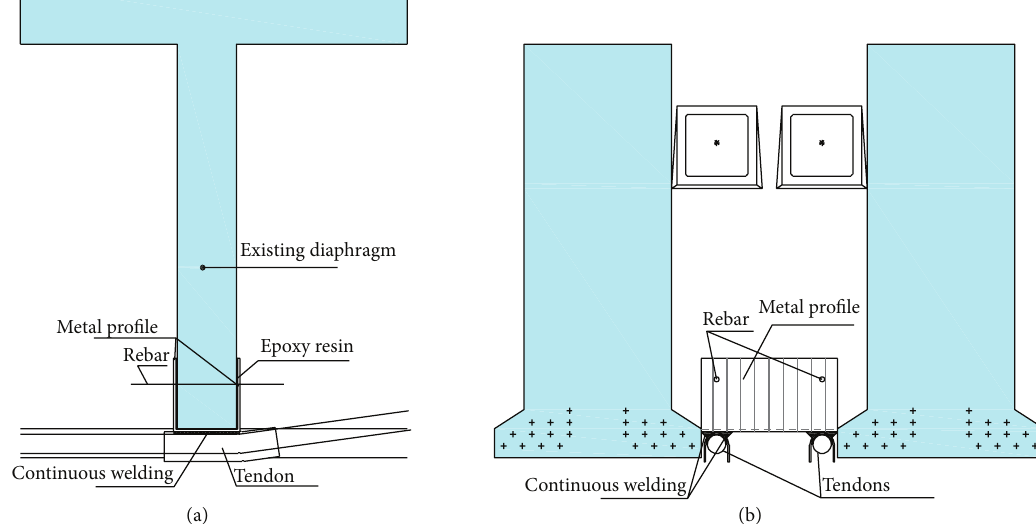
Figure 6: Details of connection between existing bridge and metallic saddle of